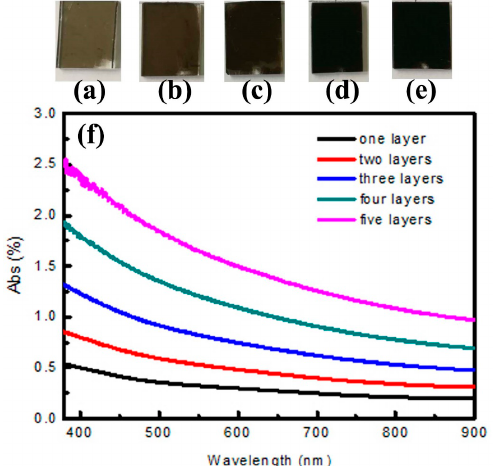
Figure 5. Optical properties of CS self-assembly films with different layers: ( a – e ) the photographs of five samples respectively; ( f ) absorption spectra of five samples.